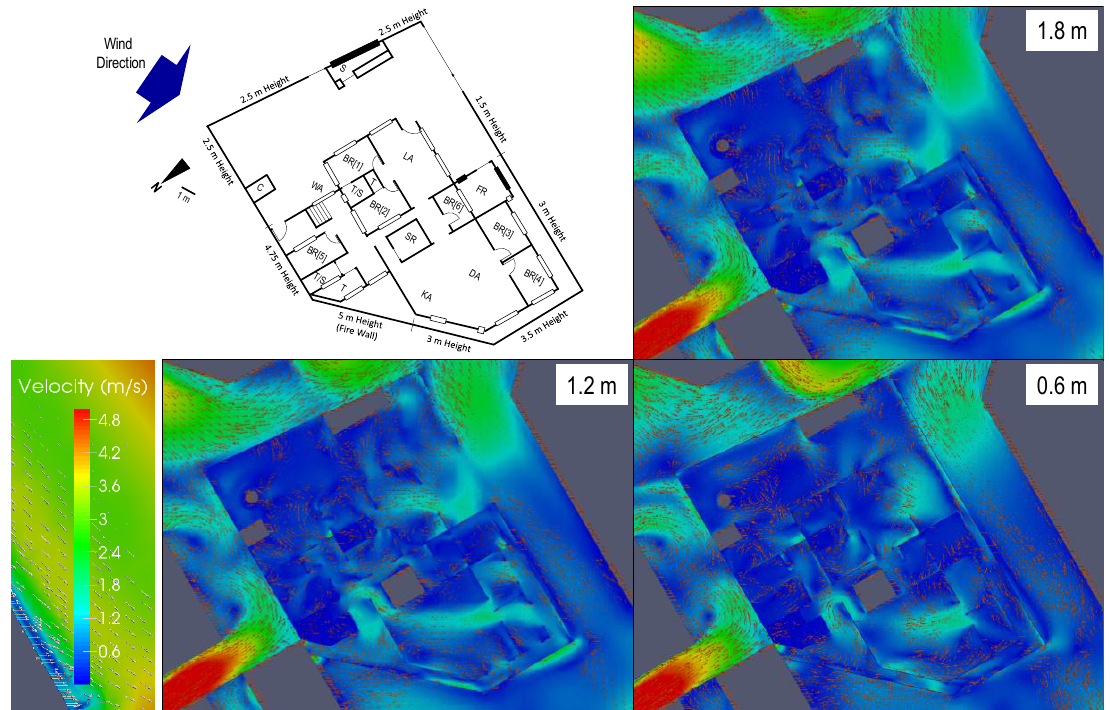
Figure 8. Case 3—High lot perimeter wall with firewall (all windows and doors opened) wind velocity around and inside the detached family house for three vertical heights (1.8 m, 1.2 m, and 0.6 m above the floor).